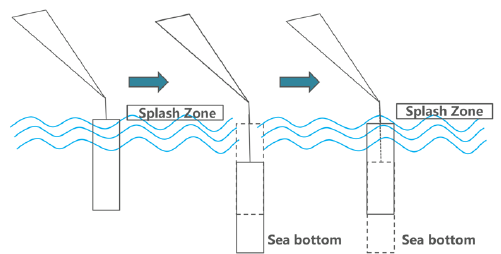
Figure 4: AOI definition for (a) target stage one, and (b) target stage